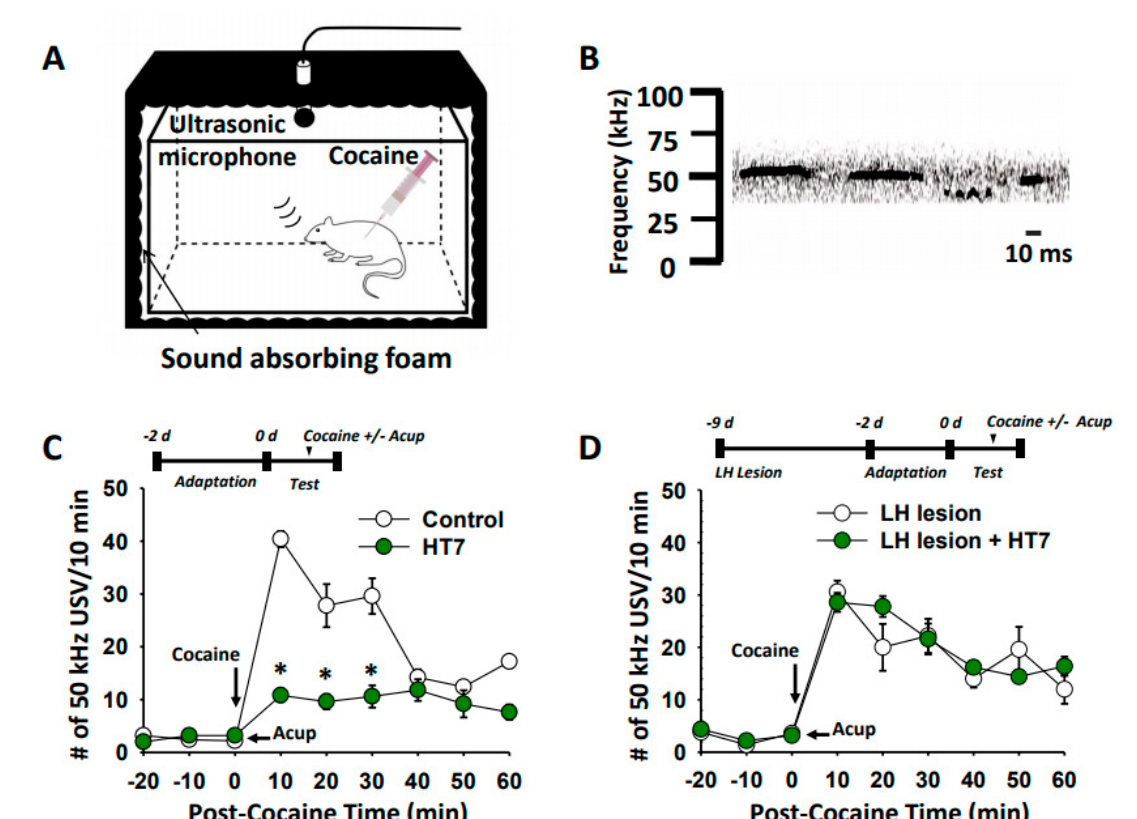
Figure 2. Effect of LH chemical lesions on acupuncture inhibition of cocaine-induced USVs. ( A ) Schematic diagram of ultrasonic vocalizations (USVs) recording in freely moving rats. ( B ) Representative traces of 50 kHz USVs following cocaine injection. ( C ) Effect of acupuncture at HT7 on cocaine-induced 50 kHz USVs in rats. Control, cocaine injection only ( n = 5); HT7, acupuncture at HT7 in cocaine-treated rats ( n = 5). * p < 0.05 vs. Control. ( D ) Effects of LH lesions on the effects of acupuncture at HT7 on cocaine-induced 50-kHz USVs . LH lesion, cocaine injection in LH-lesioned rats ( n = 5); LH lesion + HT7, acupuncture at HT7 after cocaine injection in LH-lesioned rats ( n = 5). Acup, acupuncture.